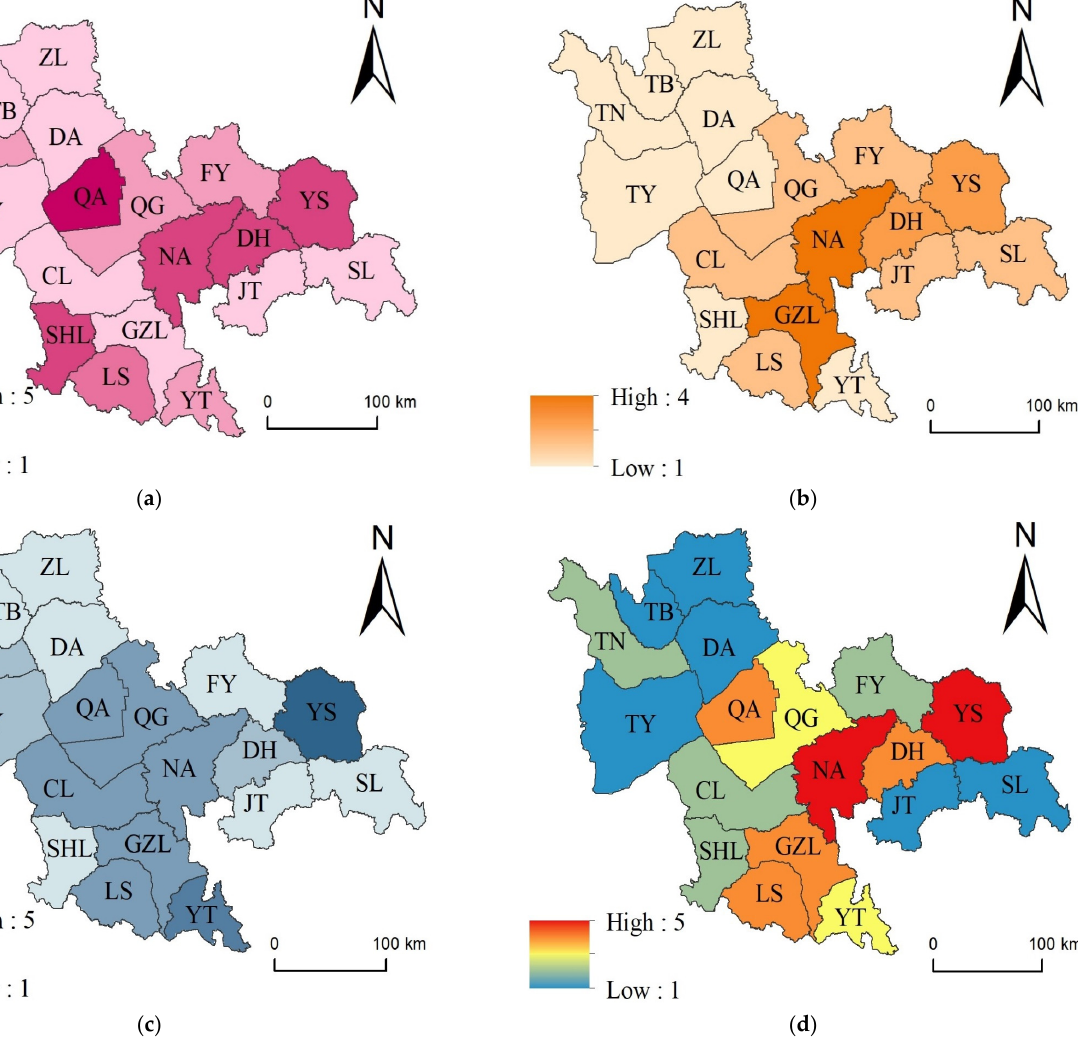
Figure 12. Various disaster mitigation capabilities in study area: ( a ) distribution of emergency management capacity levels; ( b ) distribution of resource security capacity levels; ( c ) distribution of agricultural modernization levels; ( d ) distribution of integrated disaster reduction capacity levels.